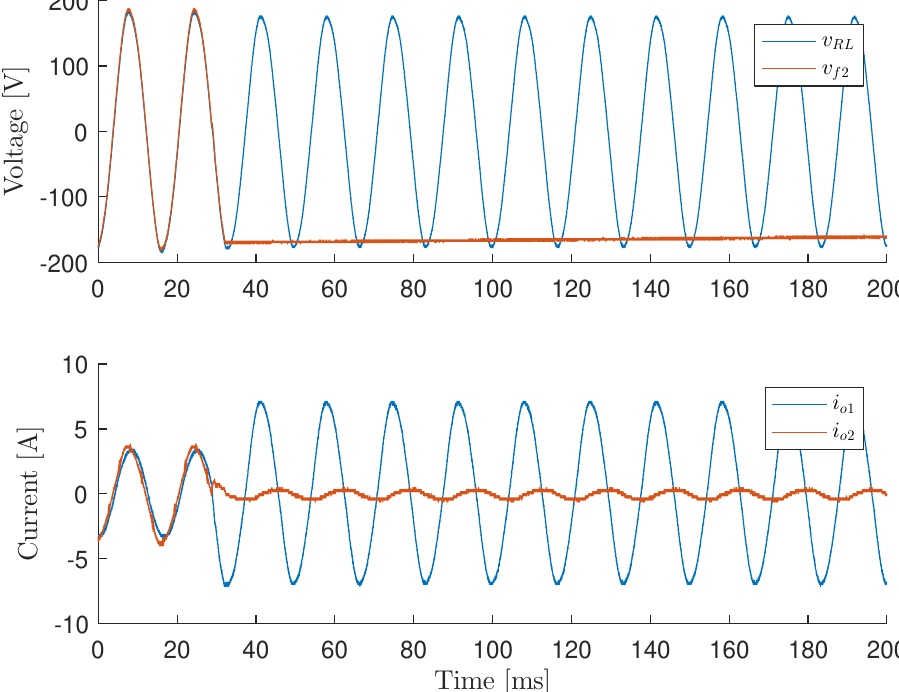
Figure 16. Disconnection of the second inverter from microgrid. The measured voltages are v f 2 and v RL . Once requested to disconnect, the inverter goes to a state where the PWM is deactivated, so the filter voltage after this event will tend to zero. The capacitor discharge, compared to the network frequency, is slow. This ends up generating the “continuous” signal seen in the graph of Figure 16. Another point to be highlighted is the reduction of the voltage in the load after the Inverter 2 is